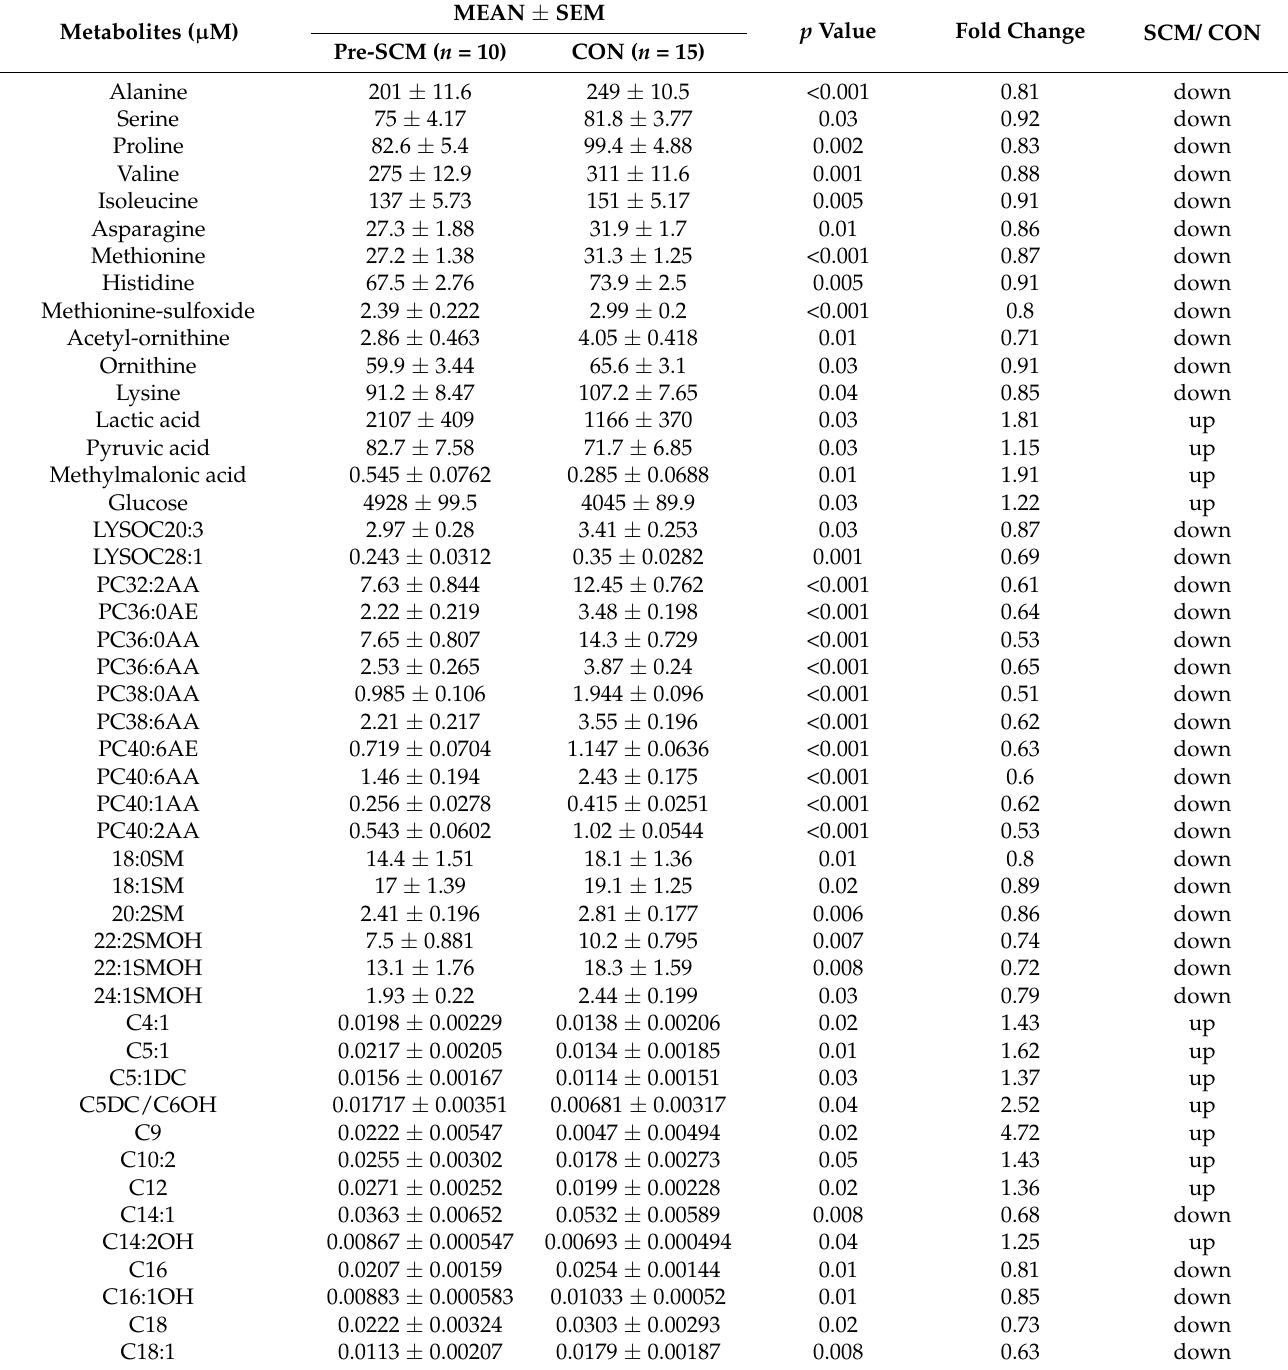
Table 5. Concentration of serum metabolites (MEAN ± SEM, ( p ≤ 0.05)) in pre-subclinical mastitis cows only (pre-SCM, n = 10) and healthy controls (CON, n = 15) cows at − 4 weeks before parturition, as identified by